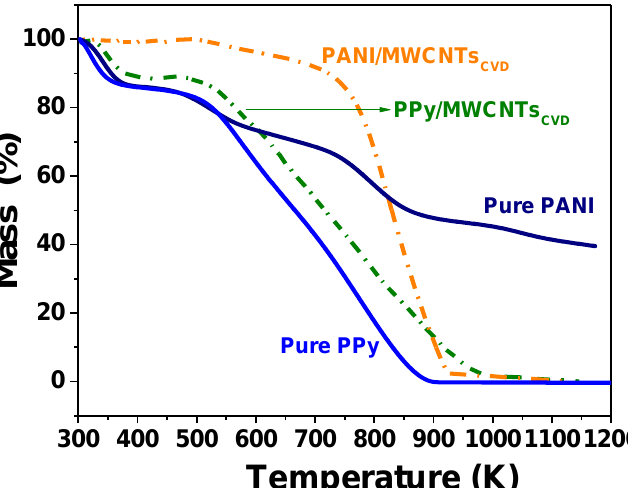
Figure 12. TGA thermograms of PPy/MWCNTs, PANI/MWCNTs composites using synthesized carbonaceous structures and their comparison with pure polymers.